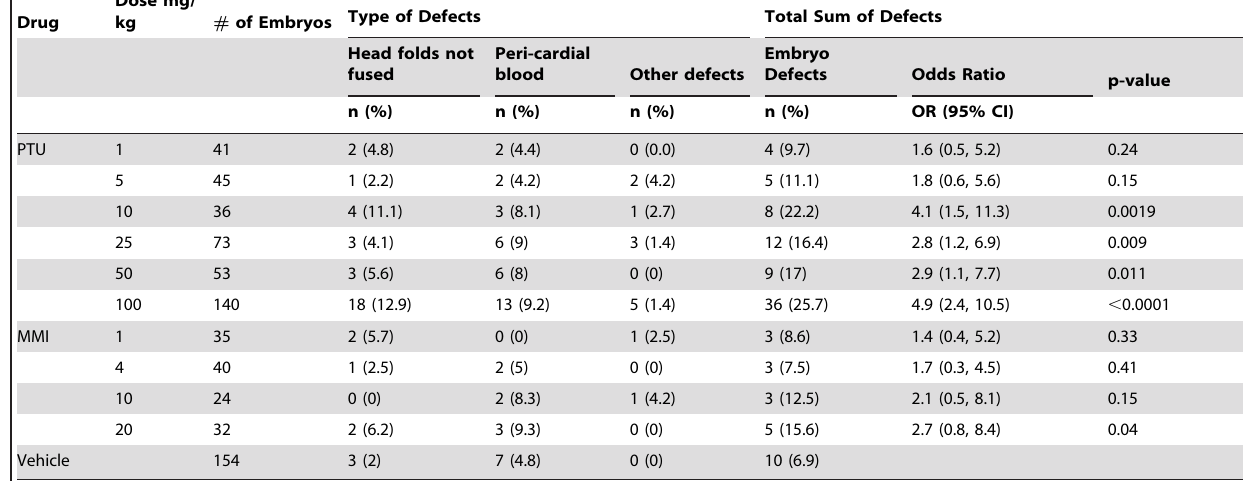
Vehicle 154 3 (2) 7 (4.8) Includes live embryos only. Chi-square \ test.